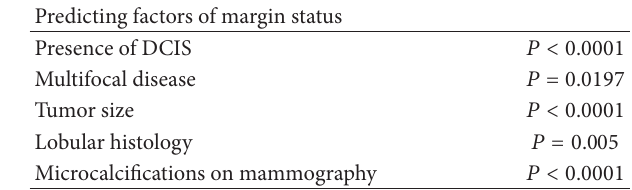
Table 1: Local recurrence rates and corresponding threshold dis- tances for negative margins are indicated for each study.